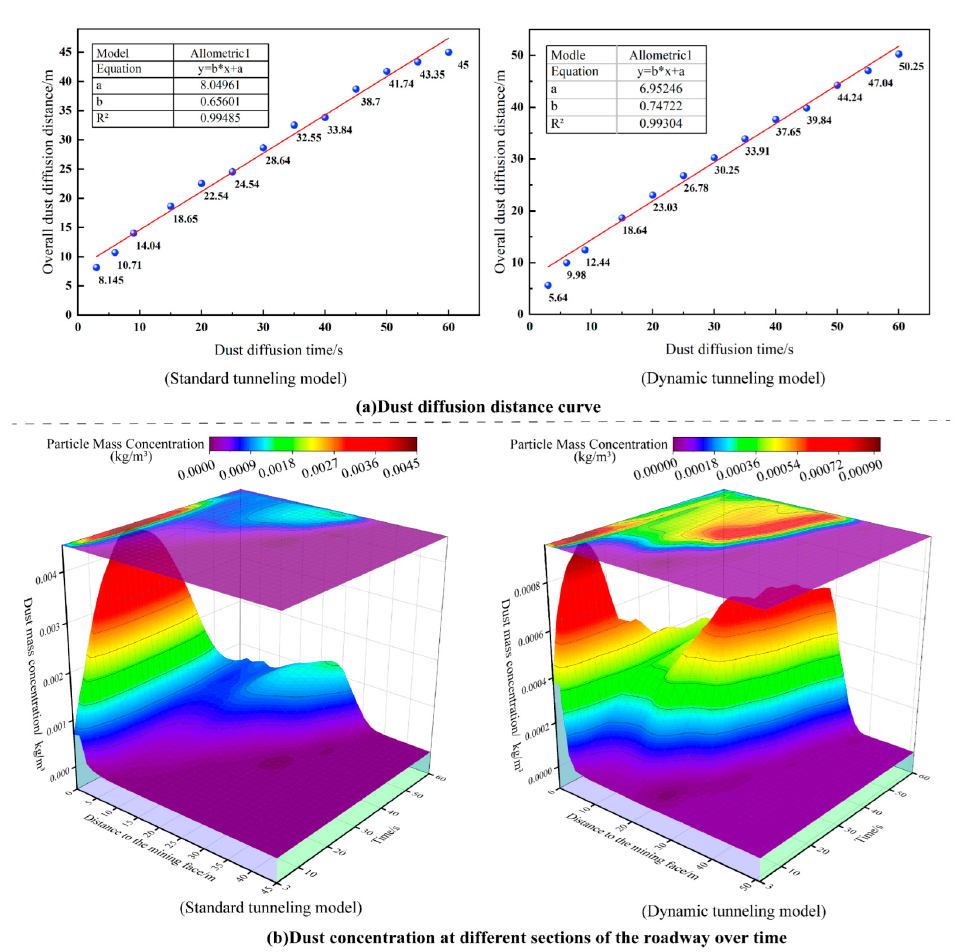
Figure 15. Analysis of dust diffusion in fully mechanized excavation.